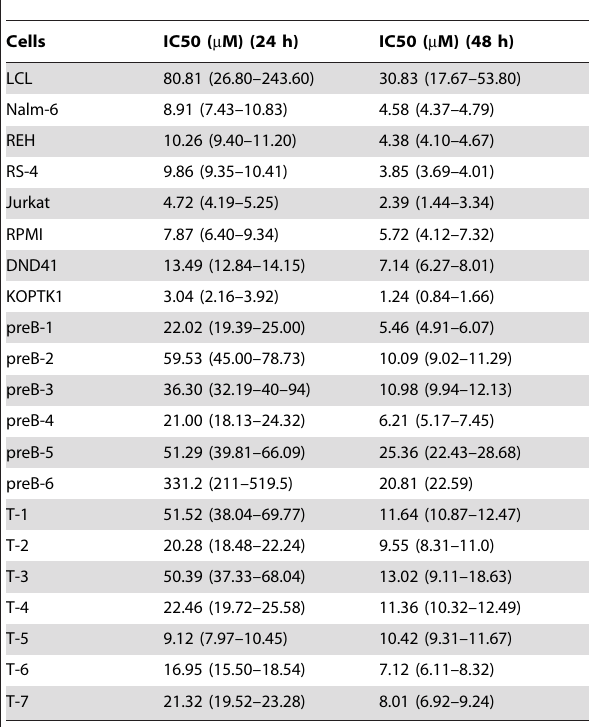
Table 1. IC50 values in leukemic cell lines, primary lymphoblast cells from pre-B ALL and T-ALL